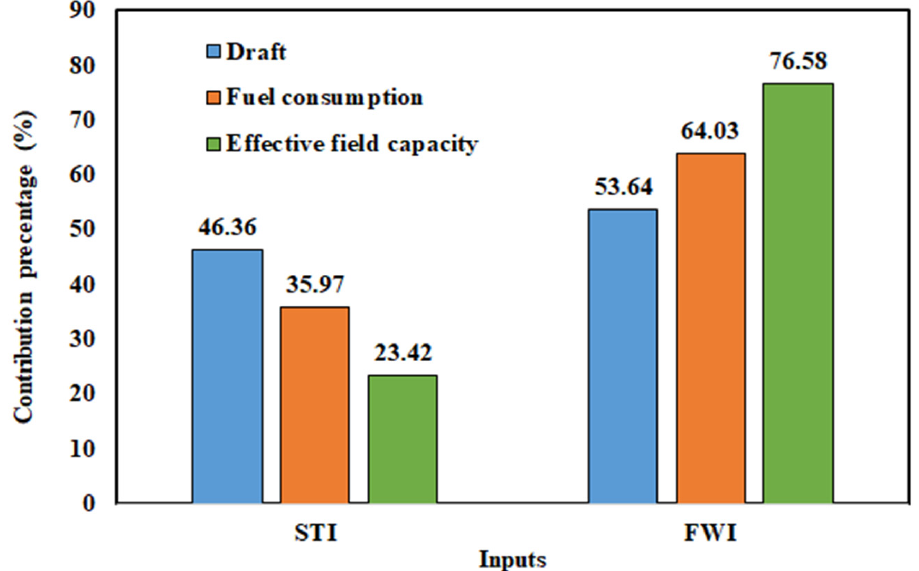
Figure 12. Contribution percentages of the input parameters (STI and FWI) to the performance attributes of draft force, fuel consumption, and effective field capacity when using ANN model.